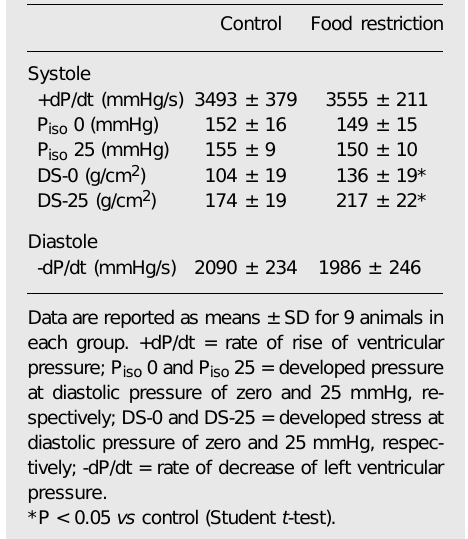
Table 3. Functional study of the left ventricle in an isolated Langendorff heart preparation.